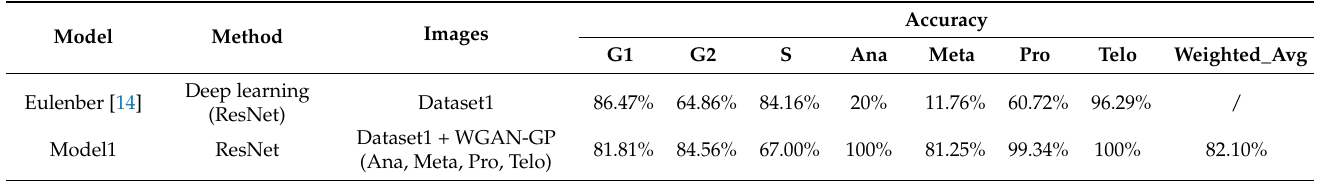
Table 10. The seven-stage classification accuracy on the same dataset (Jurkat datasets).